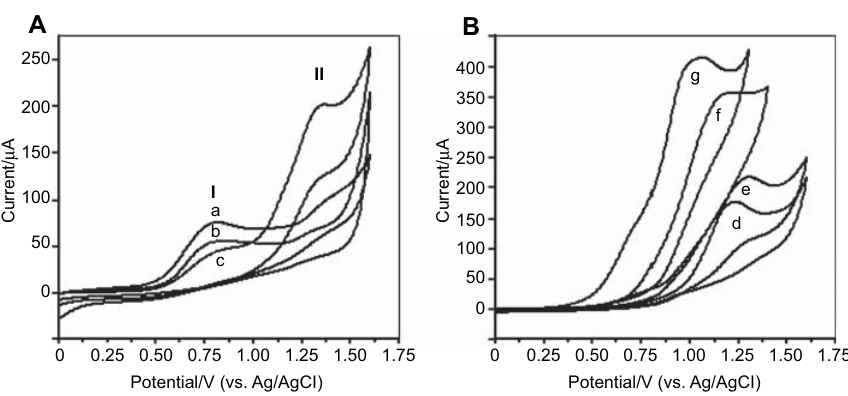
Figure 1 Cyclic voltammograms at different pH values. (A) (a) Britton-Robinson buffer pH 2.0, (b) phosphate buffer pH 3.0, (c) acetate buffer pH 4.8. (B) (d) Britton-Robinson buffer pH 6.0, (e) Tris buffer pH 7.0, (f) Britton-Robinson buffer pH 9.0, and (g) phosphate buffer pH 12.0. TU concentration, 1.31 m m ; scan rate, 100 mV s -1 .